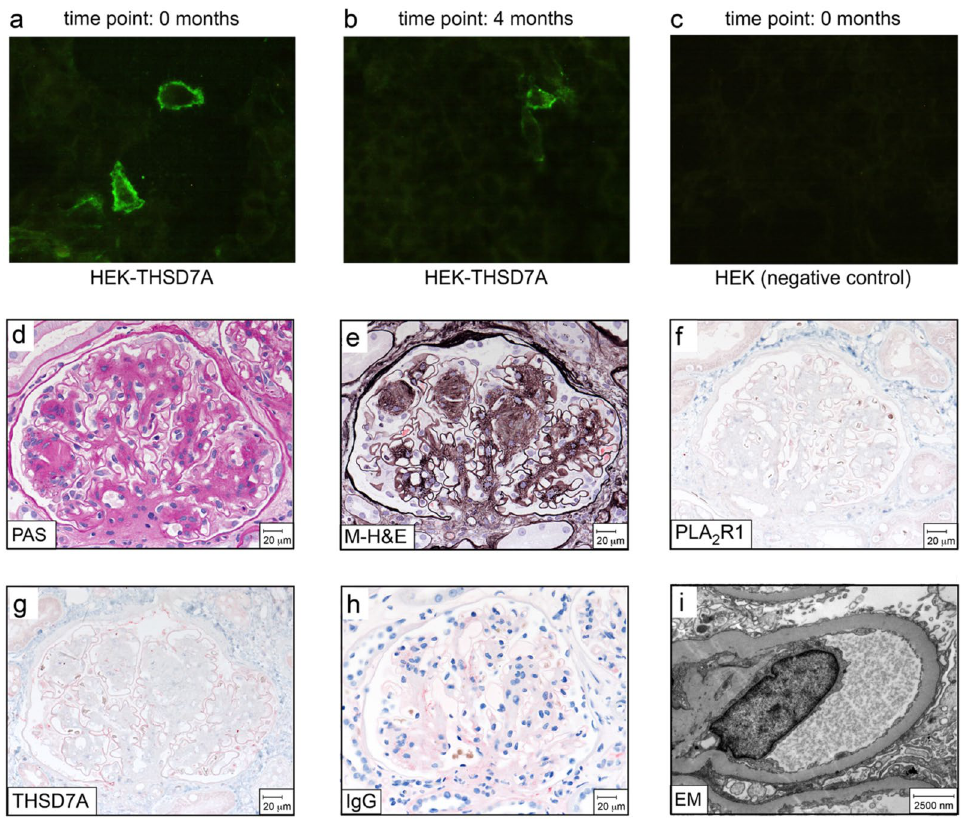
Figure 1. Findings in patient serum and renal biopsy. ( a – c ) Representative photographs of the results of the IIFT assay. ( a ) At the time of the initial presentation of the patient (0 months), THSD7A-antibodies are detectable in the IIFT analysis at a titre of 1:10. ( b ) The same level of positivity is observed after 4 months. ( c ) The negative control HEK cells, which are transfected with an empty expression vector do not express THSD7A and are analysed simultaneously with the patient serum “0 months”, show no detectable fluorescence. Incubation of the THSD7A-expressing HEK cells with a healthy serum showed no signal (not shown). The IIFT results were evaluated blinded in two different laboratories, in each lab by at least two different investigators. ( d ) PAS staining and ( e ) methenamine silver-H&E (M-H&E) staining reveal lesions typical for diabetic nephropathy, i.e. nodular glomerulosclerosis. Immunohistochemical staining for ( f ) PLA 2 R1, ( g ) THSD7A and ( h ) IgG show no signs of MN. ( i ) By electron microscopy no electron dense subepithelial deposits, which are characteristic for MN, are